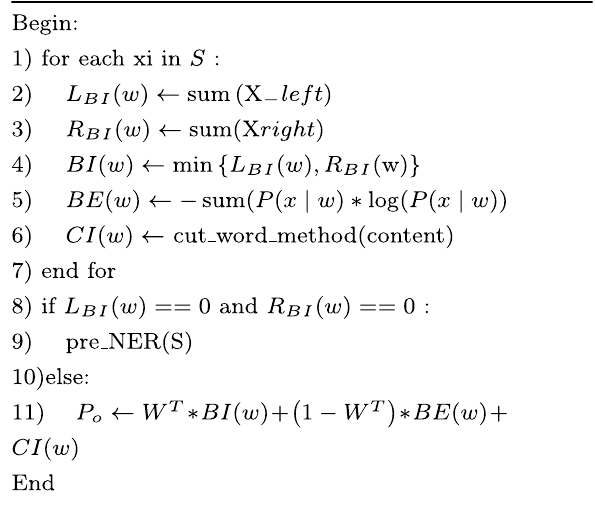
Table 1 Entity boundary detection